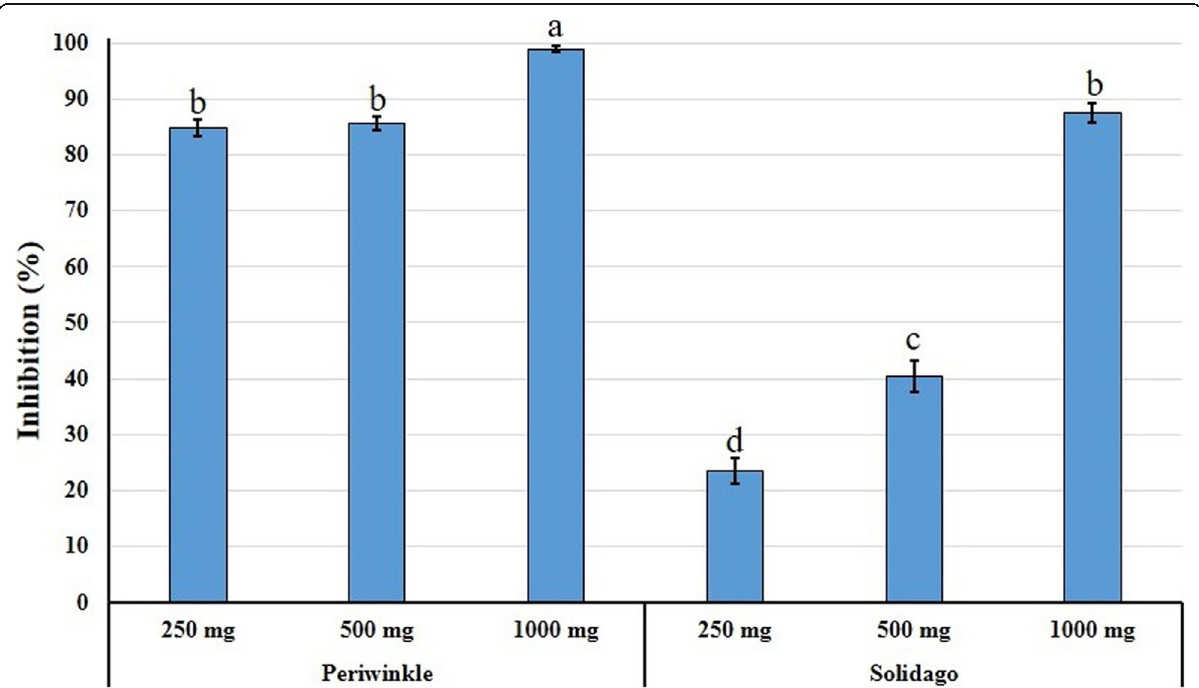
Fig. 1 Efficacy of periwinkle and solidago aqueous extracts at three concentrations on egg hatching of M. incognita egg masses. Columns bear different letters that are significantly different at p < 0.05 according to Duncan ’ s multiple range